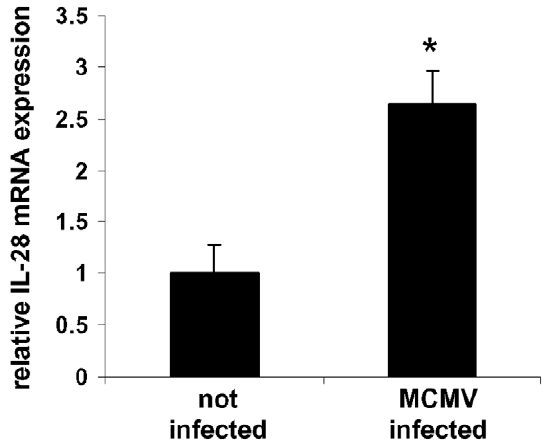
Figure 6. IL-28 expression is increased in murine viral hepatic infection. Mice were infected with 1 6 10 6 pfu of murine cytomegalo- virus for 45 hours. Quantitative PCR analysis demonstrated an increase of IL-28 expression of 2.7-fold in comparison to not infected control mice. * p , 0.005 vs. not infected. No IL-29 gene has been described in mice, therefore not allowing expression analysis of this